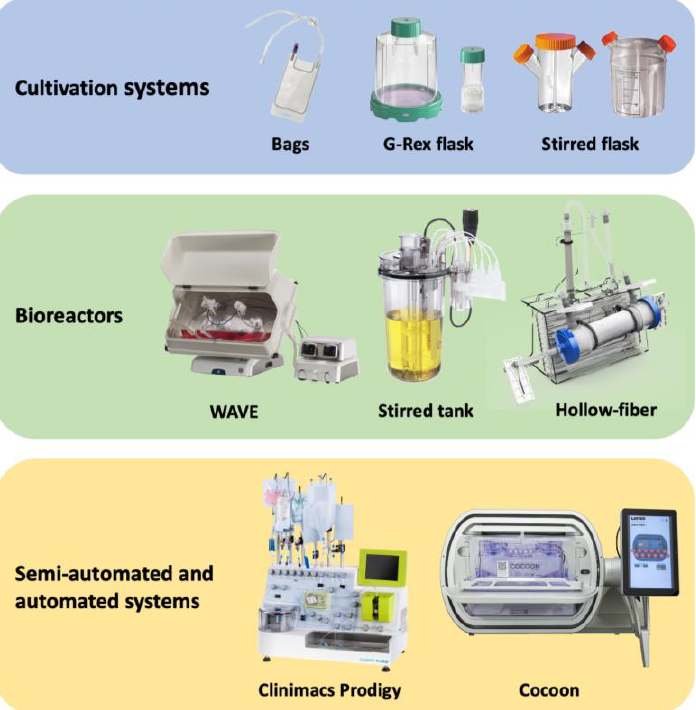
Figure 1. Primary types of cell cultivation systems, bioreactors, and automated systems. Cell cultivation systems are simple, require additional equipment, and involve manual cell processing at all steps. Bioreactors are more mechanized and allow certain steps to be completed in a closed aseptic mode. Semi-automated and automated systems are highly autonomous and require minimal human intervention.